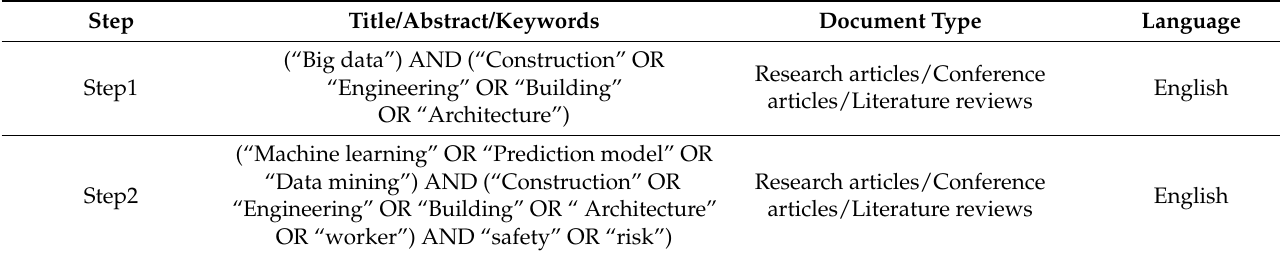
Table 1. Literature searching